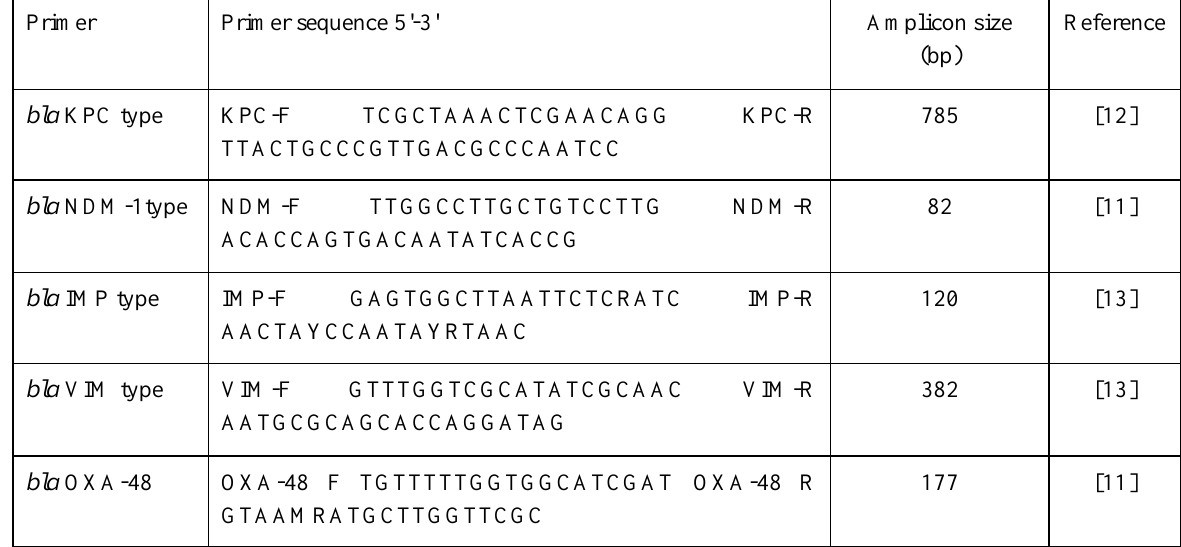
Table 1. PCR primers used in carbapenemase genes